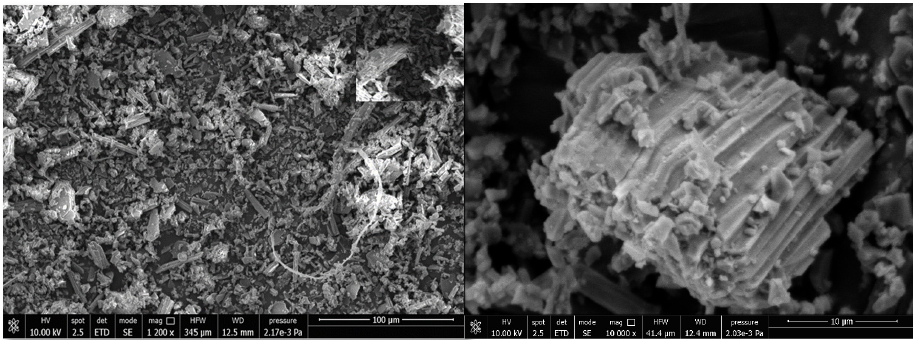
Figure 2. Micrographs at 1200 × and 10,000 × of shell powder. Figure 2 . Micrographs at 1200× and 10,000× of shell powder .